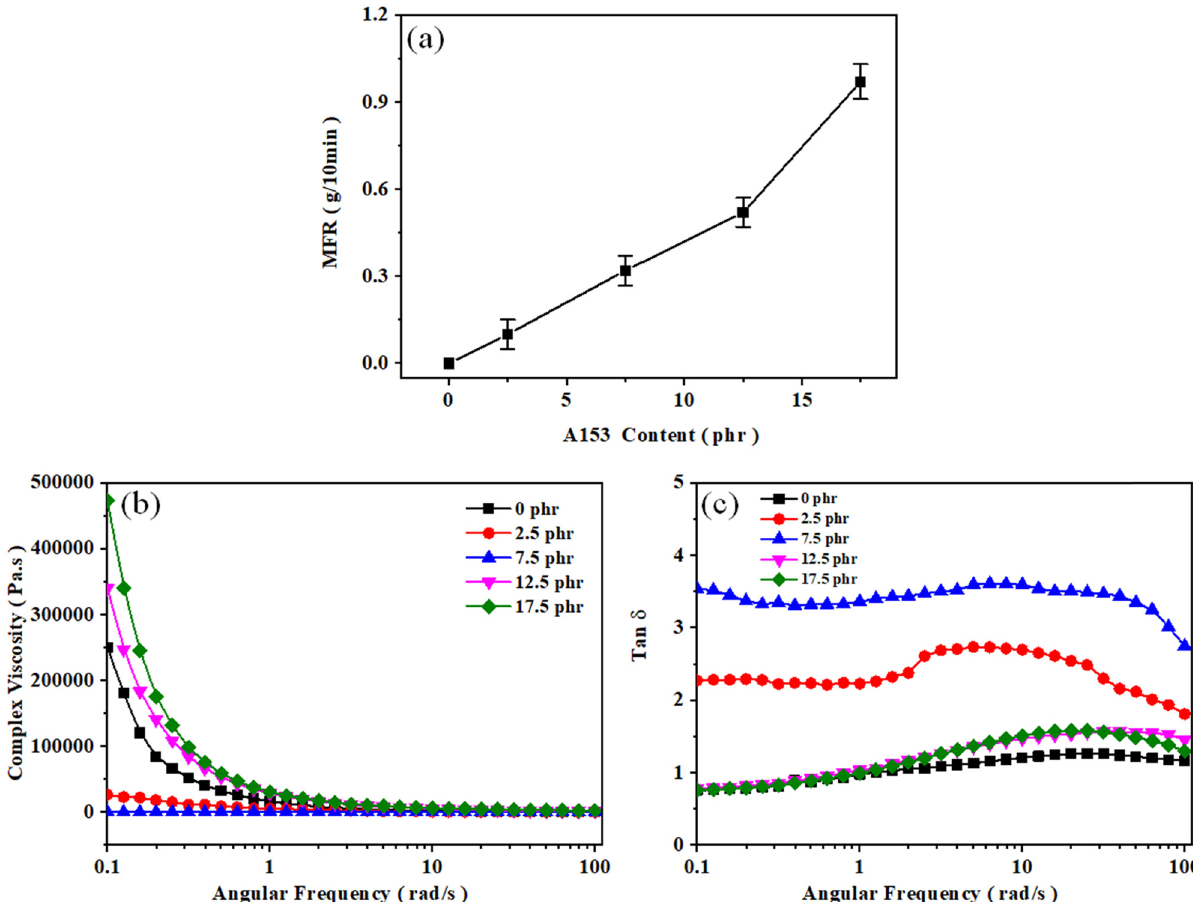
Figure 5: E ff ect of A153 content on processability of PP composites: ( a ) MFR, ( b ) viscosity, and ( c ) dielectric